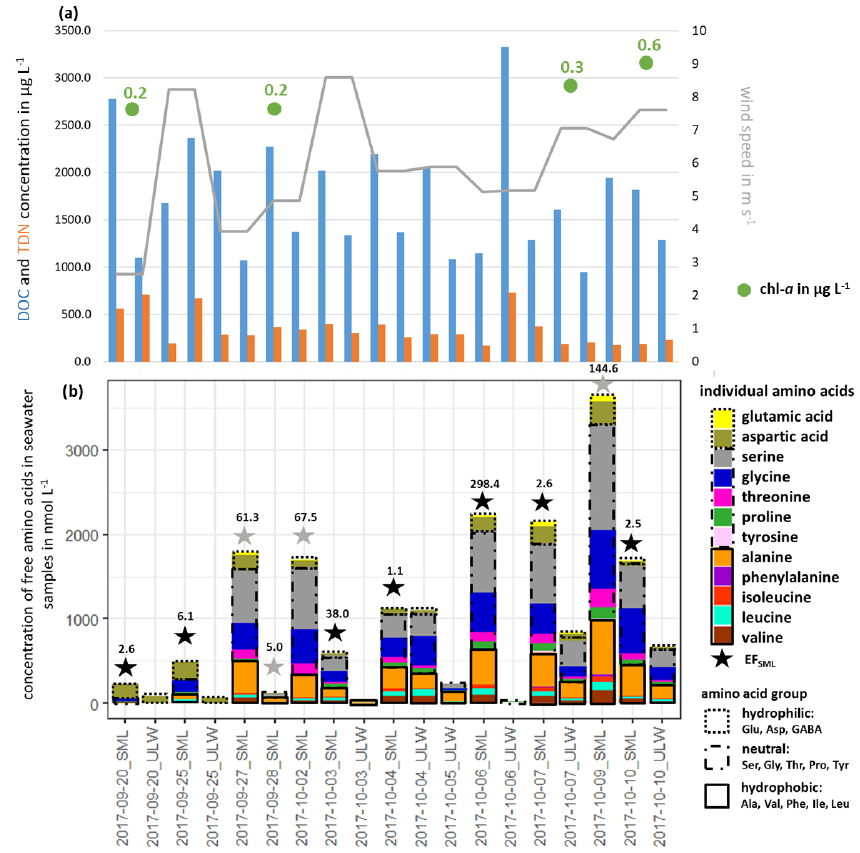
Figure 1. (a) DOC, TDN and chl a concentrations in seawater and wind speed and (b) individual FAA concentration in the seawater samples and the enrichment factor EF SML of (cid:80) FAA. EF SML is based on measurements (black stars), EF SML is based on LOQ/2 estimation (gray